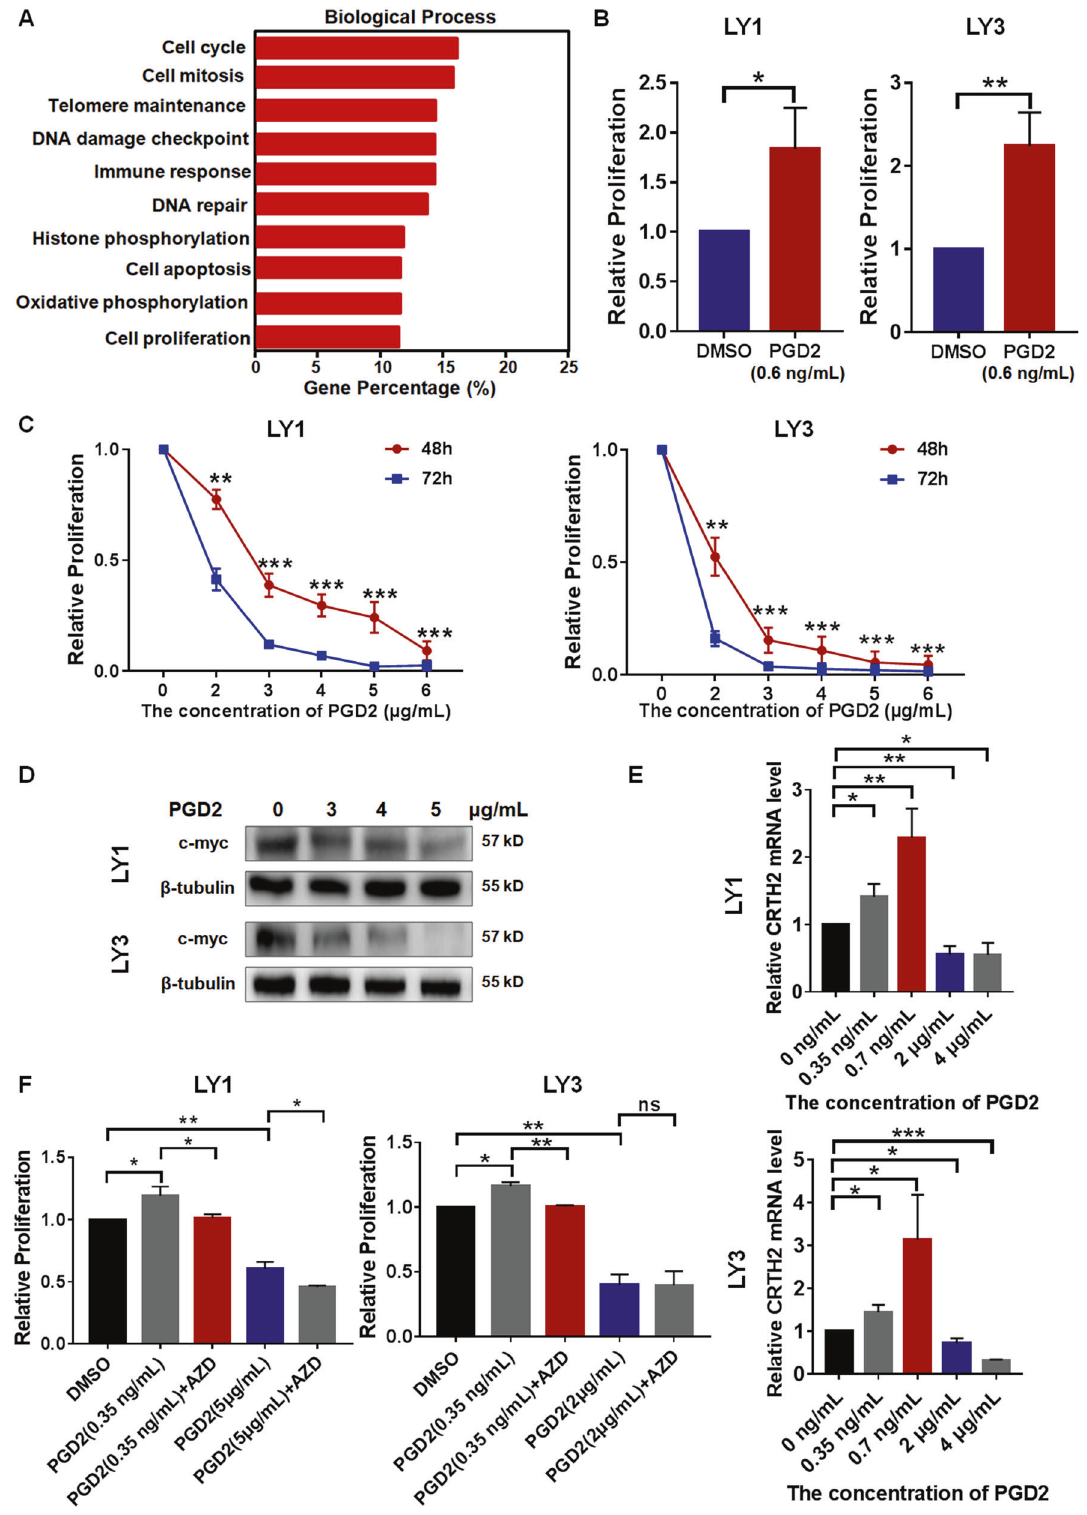
Fig. 2 Different concentration of PGD2 displayed distinct effects on DLBCL cell proliferation. A GO analysis of CRTH2 associated genes ( p < 0.05) based on GSE31312 database indicated the association between CRTH2 and tumor development. B The treatment with PGD2 (0.6 ng/ mL), similar concentration to serum PGD2, promoted cell proliferation. C , D High-concentration PGD2 dose-dependently decreased cell proliferation and c-myc expression in DLBCL cells. E Low-concentration PGD2 increased the expression level of CRTH2 while high-concentration PGD2 signi fi cantly decreased it. The expression of CRTH2 in DLBCL cells without drug treatment was adjusted to 1. F AZD1981 (AZD), the CRTH2 inhibitor, rescued the pro-proliferation effects of low-concentration PGD2, but not the anti-proliferation effects of high-concentration PGD2 in DLBCL cells. DLBCL cells were treated with drugs for 48h. Data are shown as the mean ± SD. * p < 0.05; ** p < 0.01; *** p < 0.001.